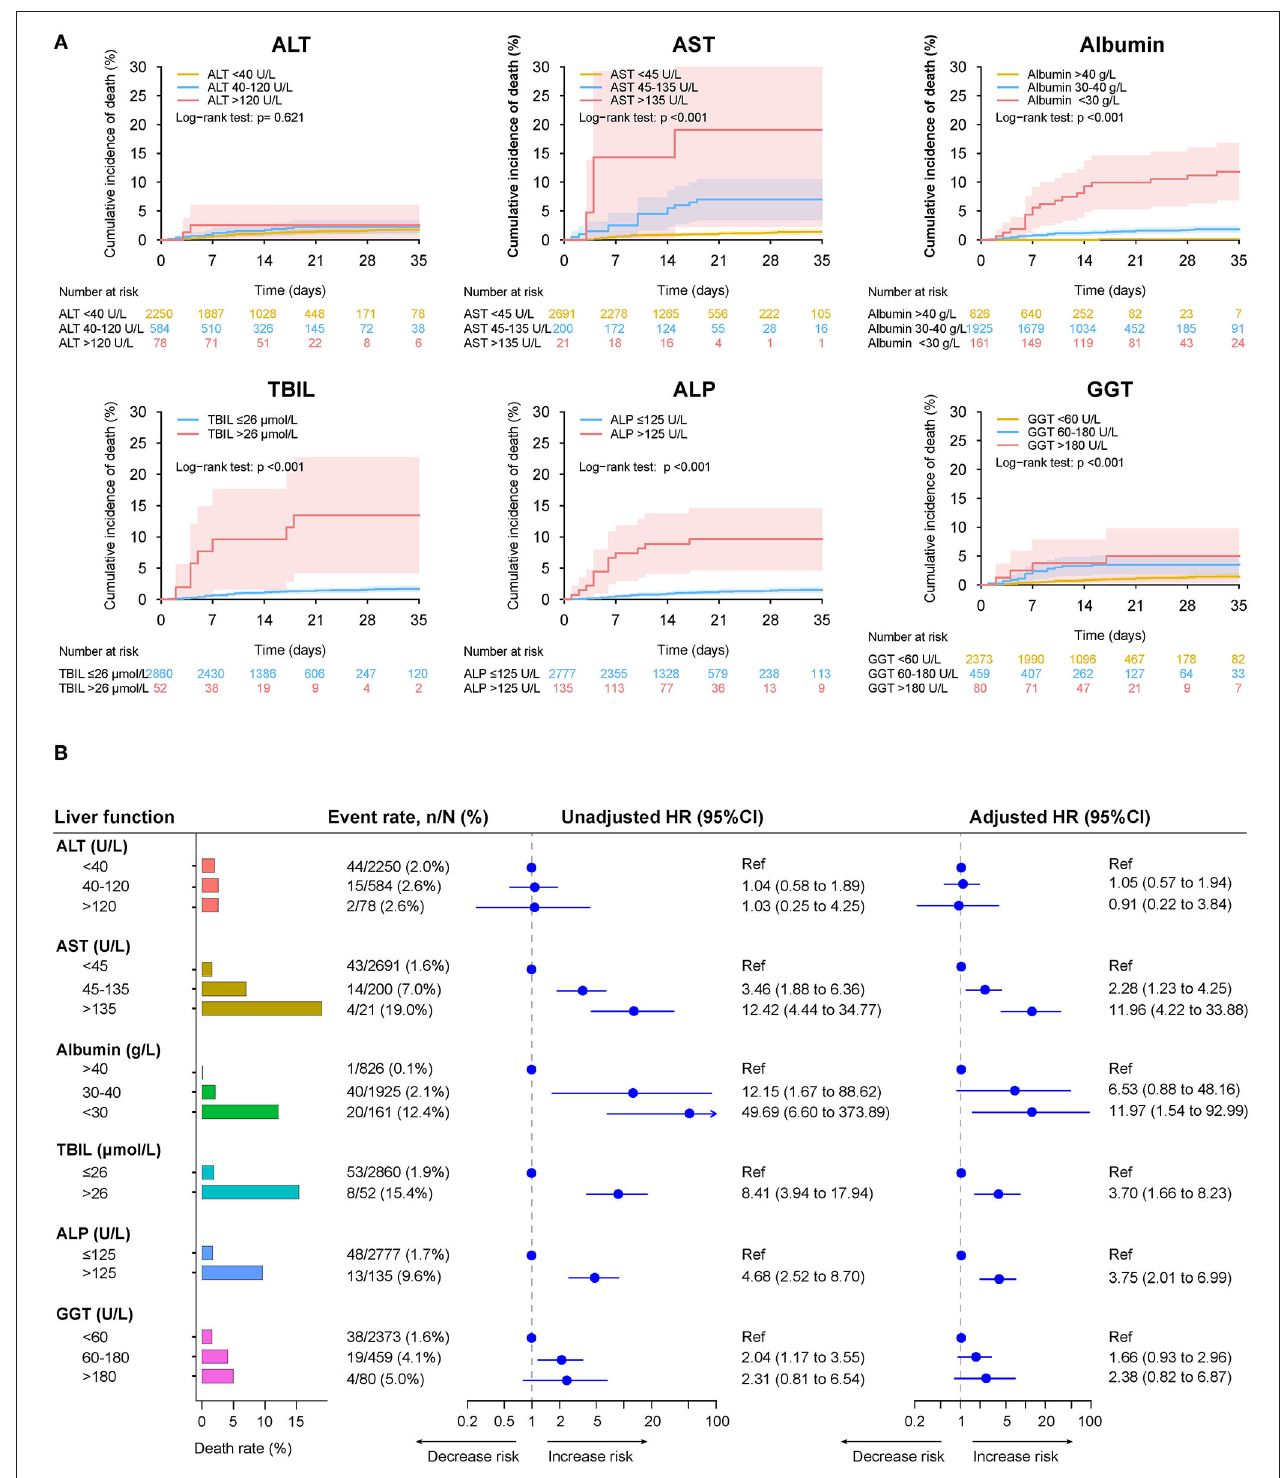
FIGURE 8 | Mortality during hospitalization in patients with different level of baseline liver function tests. (A) Cumulative incidence of death in patients with different level of liver function test on admission. (B) Death rate in patients with different level of liver function test on admission, the unadjusted adjusted effect of liver function test at different level on the mortality during hospitalization. Adjusted HRs are derived from multivariate Cox regression models, adjusted for age, gender, comorbidities (hypertension, cardiovascular disease, diabetes, chronic pulmonary diseases, cerebrovascular disease, malignancy, autoimmune disease) and chronic liver diseases (hepatitis B virus infection, hepatitis C virus infection, autoimmune liver disease). ALT, alanine aminotransferase; ALP, alkaline phosphatase; AST, aspartate aminotransferase; CI, confidence interval; GGT, gamma-glutamyltransferase; HR, hazard ratio; TBIL, total bilirubin.